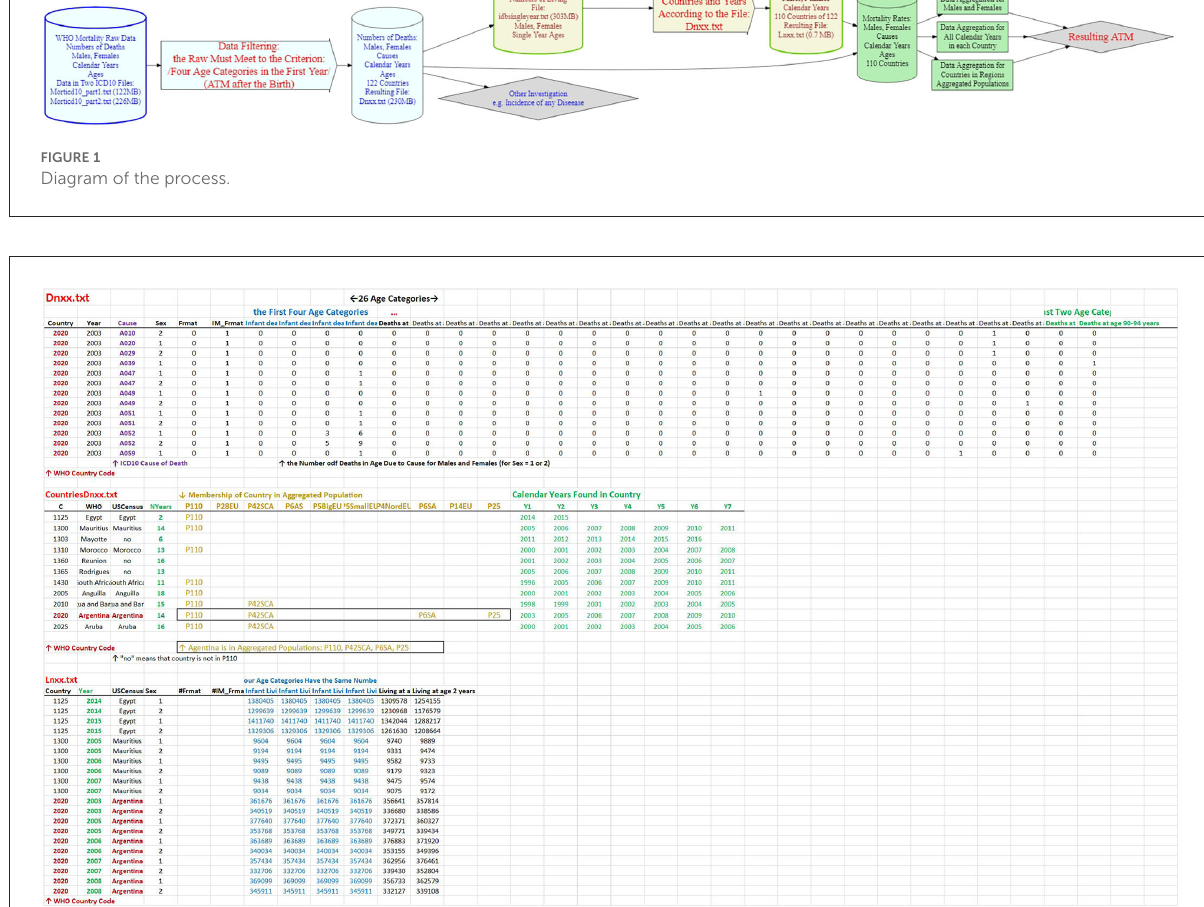
FIGURE2 Structure of three main files. The structure of the two files “Dnxx.txt” and “Lnxx.txt” is similar. Each row contains the numbers of deaths in “Dnxx.txt” and the numbers living in “Lnxx.txt,” in a specific calendar year, for men and women separately in age categories. The first two columns contain country codes and calendar years in both files. The third column contains the cause of death in “Dnxx.txt” while the country name in “Lnxx.txt.” The other columns have the same meaning in the two files. The fourth column contains sex, the next two columns contain an index of WHO format of age categories, and the last columns represent 26 age categories (columns: 7, 8, …32). The file “ContriesDnxx.txt” contains information about a specific country. The columns contain the WHO code, the name of the country used in WHO, the name of the country used in the US Census Bureau, and the number of calendar years. Columns 5–14 contain the indication if the country was used in aggregated population (a specific column corresponds to a specific aggregated population). The last columns contain the list of calendar years found in the specific country in the WHO